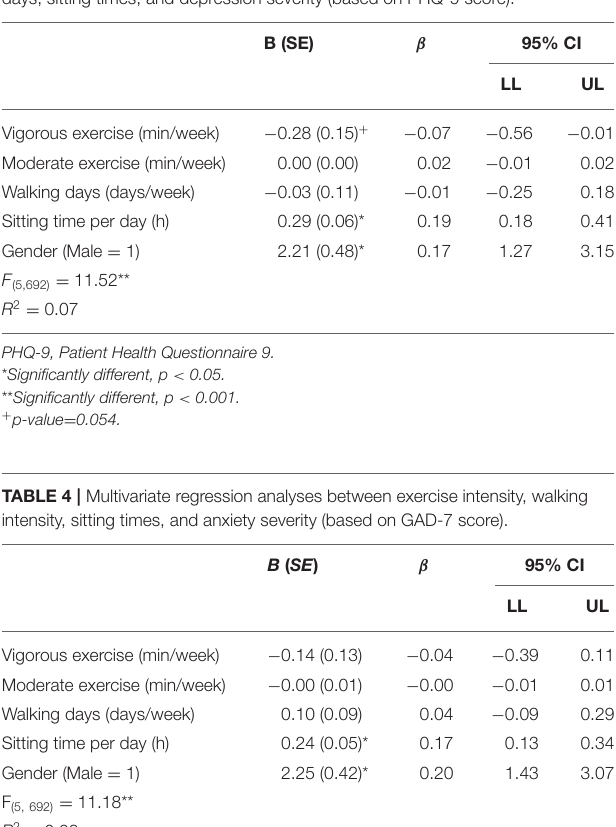
TABLE 3 | Multivariate regression analyses between exercise intensity, walking days, sitting times, and depression severity (based on PHQ-9 score).